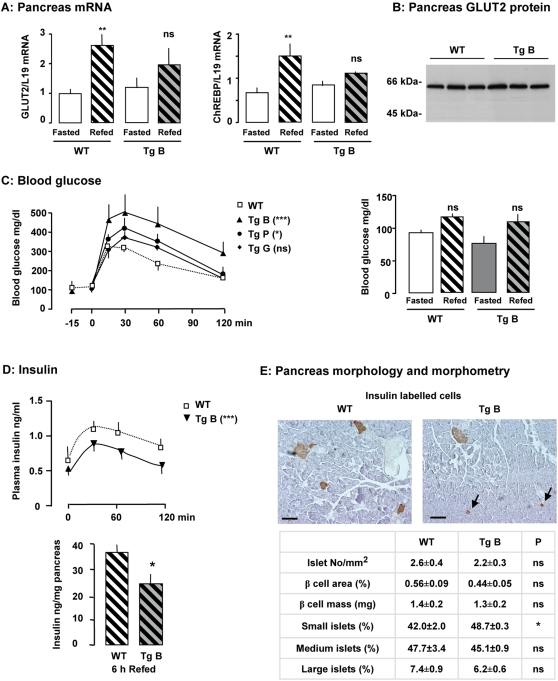
Pancreatic function in mice after impairment of extracellular sugar detection.A: Effect of a glucose-rich diet on gene expression in the pancreas of wild-type (WT) and transgenic (Tg) mice fasted for 48h and refed for 15 h. Levels of mRNA were analyzed by real-time PCR. Values are presented as means±S.E.M. (n = 3 to 4 mice/group). Statistical differences between refed and fasted mice are indicated as **P<0.01 and ns non significant. B: GLUT2 protein levels in total membrane preparations of pancreas from mice fed a glucose-rich diet for five days. C: Left panel: Blood glucose concentrations during an oral glucose tolerance test in wild-type and transgenic mice fasted for 24 h (n = 17 for wild-type mice, n = 2 to 5 for transgenic mice). Statistical differences between transgenic and wild-type mice are indicated as ***P<0.001, *P<0.05 and ns non significant (two-way ANOVA) for the areas under the curves. Right panel: Blood glucose concentrations in wild-type and transgenic mice in the fasted state or 6 h after being refed with a glucose-rich diet. Values are presented as means±S.E.M. (n = 4 to 8 mice/group). D: Upper panel: Plasma insulin concentrations during an oral glucose tolerance test in fasted wild-type and transgenic mice (n = 10 to 13 mice/group). Statistical differences between transgenic and wild-type mice are indicated as ***P<0.001 (two-way ANOVA) for the areas under the curves. Lower panel: Pancreatic insulin content in mice 6h after being refed a standard diet. Values are presented as means±S.E.M. (n = 5 mice/group). Statistical differences between transgenic and wild-type mice are indicated as *P<0.05. E: Upper panel : Representative immunostaining with antibody against insulin of pancreatic sections from wild-type and transgenic mice. Arrows indicate small islets. The bar corresponds to 100 µm. Lower panel: Histomorphometric comparisons of islet number, size and ß-cell mass. Proportion of small islets (<25 µm) to total number of islets is statistically different indicated as *P<0.03 between transgenic and wild-type mice.